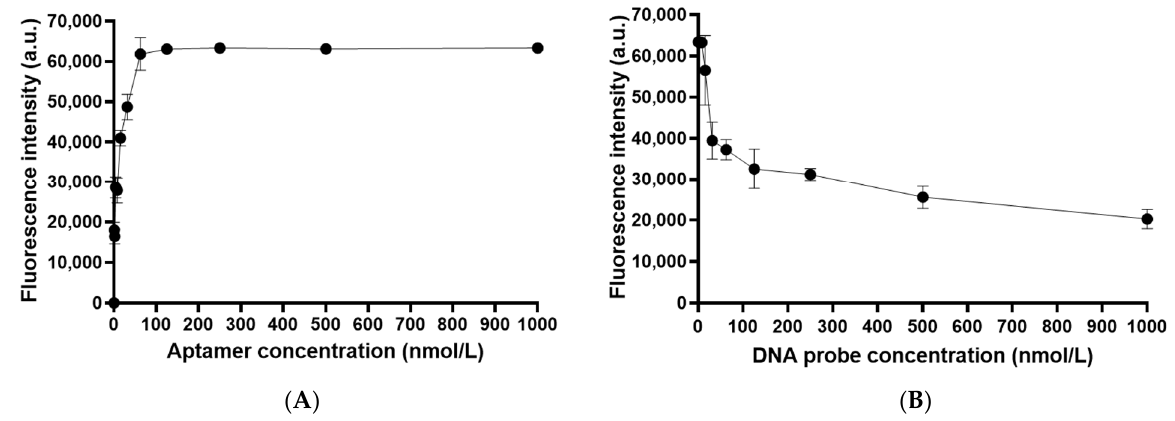
Figure 3. Optimization of the Cy3-labeled OTA-specific aptamer concentration in the development of ACSB ( A ). Fluores- cence signal response was analyzed at various concentrations of OTA-specific aptamer. Optimization of the concentration of the BHQ2-labeled DNA probe for the construction of ACSB ( B ). Fluorescence signal response was analyzed at various concentrations of DNA probe used to achieve FRET-induced fluorescence quenching of the Cy3 labeled-OTA aptamer.